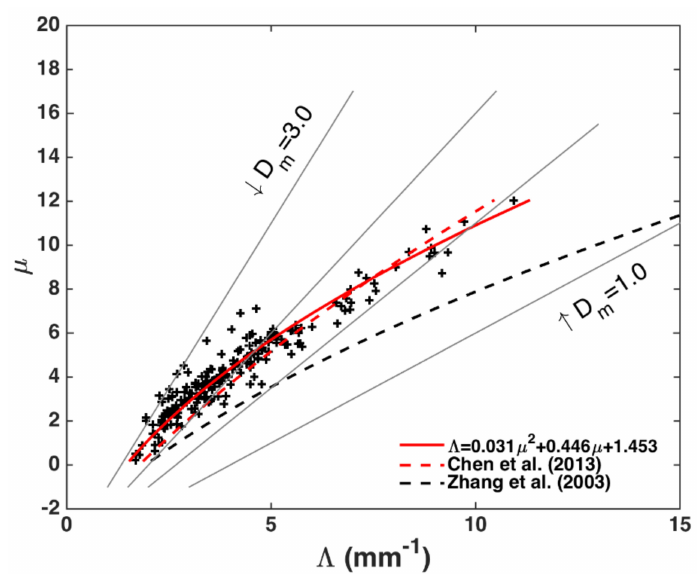
Figure 8. Scatter plot of µ – Λ values for convective rain obtained using the moment method and the truncated moment method with the filtering of total drop counts > 1000. The gray lines correspond to the relationship Λ D m = 4 + µ given the values of D m = 1.5, 2.0, 3.0, and 4.0